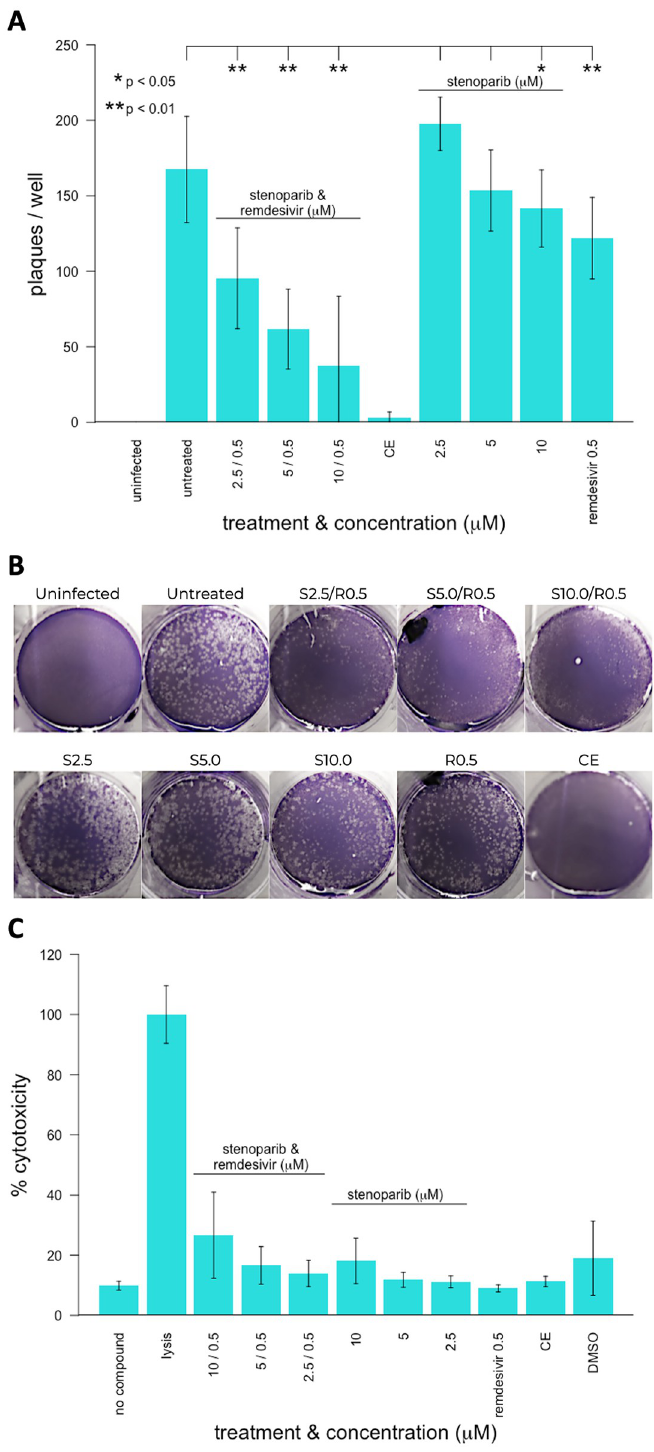
Fig 2. Activity of stenoparib and remdesivir on the alpha SARS-CoV-2 variant and cytotoxicity of stenoparib and remdesivir in Vero E6 cells. (A) Virus plaque assays. Vero E6 cells were infected for 2 hours with SARS-CoV-2 alpha variant, washed, and overlaid with low-melting temp agarose/MEM with or without stenoparib and/or remdesivir at the concentrations indicated. The cell monolayers were fixed with 4% paraformaldehyde and stained with 0.1% crystal violet prior to manual counting of plaques. The experiment was performed using technical triplicates and error bars